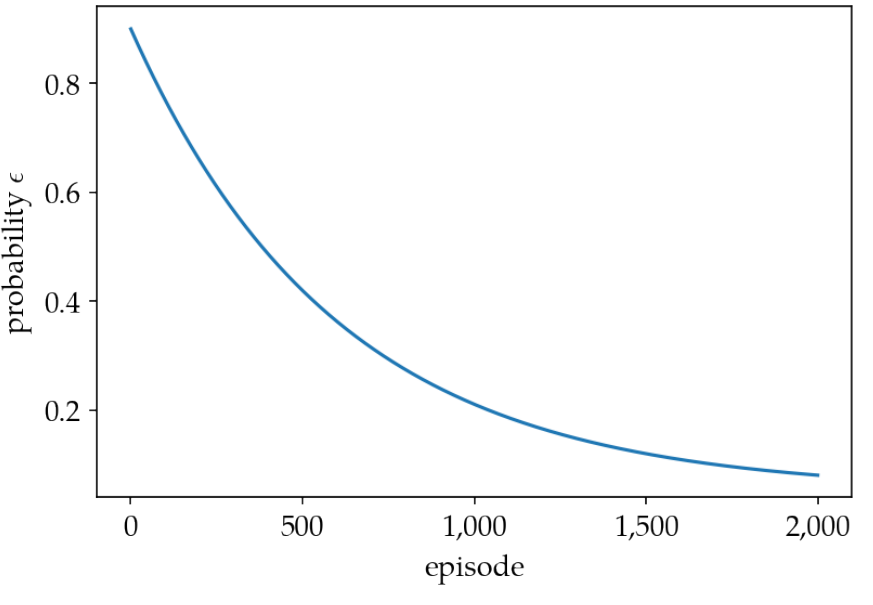
Figure 16. Plot of random probability for (cid:101) -greedy policy during training (three-day episode